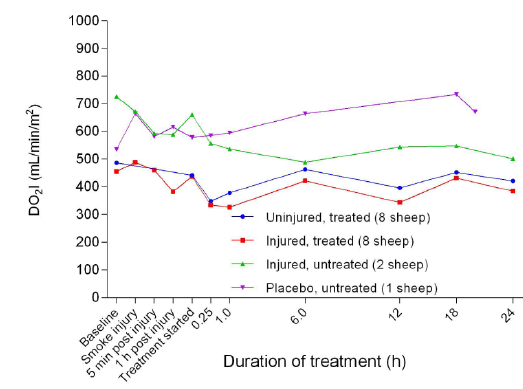
Figure 37. Oxygen delivery index (DO not shown) in smoke and non-smoke injured sheep that received extracorporeal life support as compared to that in untreated